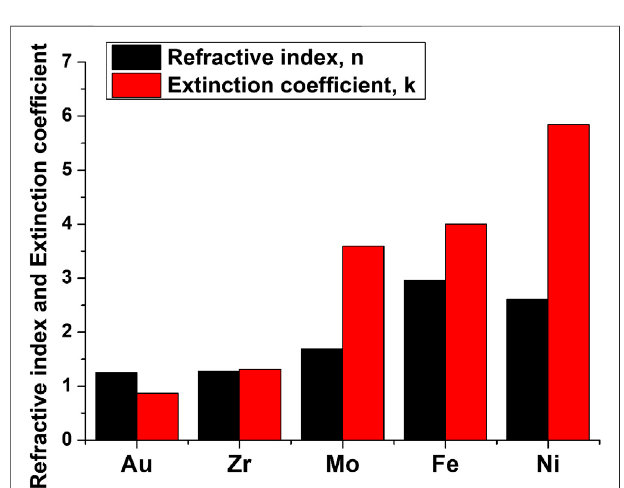
FIGURE 4 | Refractive index and absorption coef fi cient of metals at 1,064 nm wavelength. Data obtained from the database https://